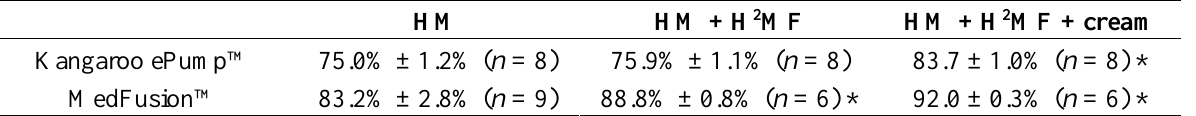
Table 1. Fat delivery efficiency of HM, HM + H 2 MF, and HM + H 2 MF +